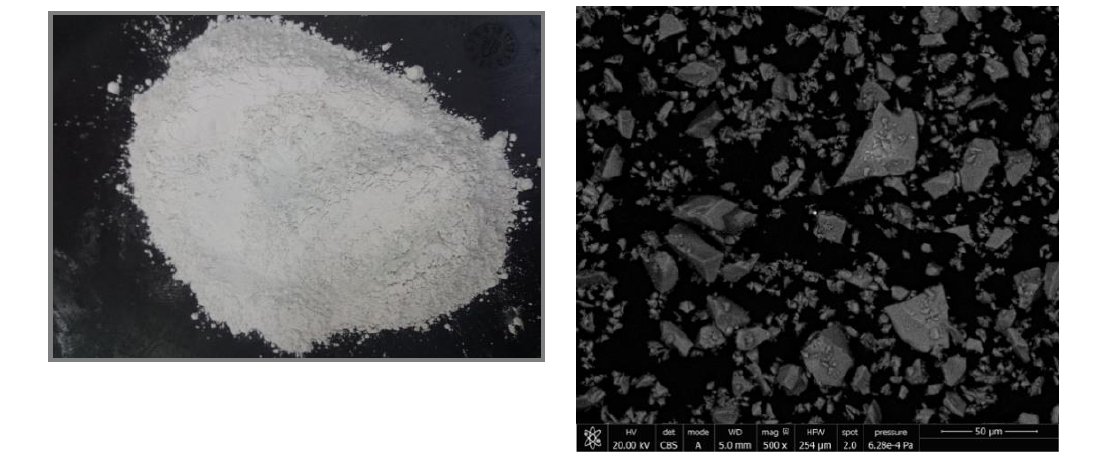
Figure 1. GGBFS particle size analysis. Materials 2020 , 13 , 561